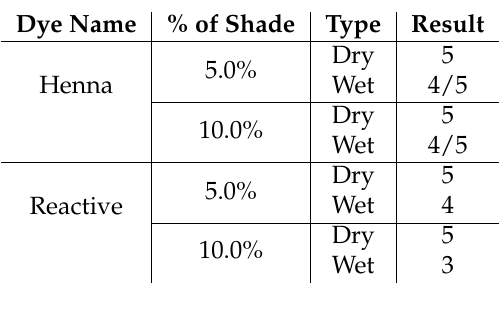
Table 1. Effect of color fastness to rubbing